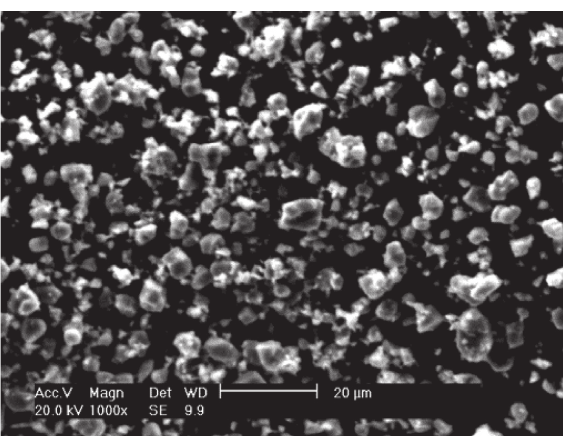
Figure 2: Topography of TiC powder used for laser cladding. Table 2: The experimental parameters applied in the laser cladding.